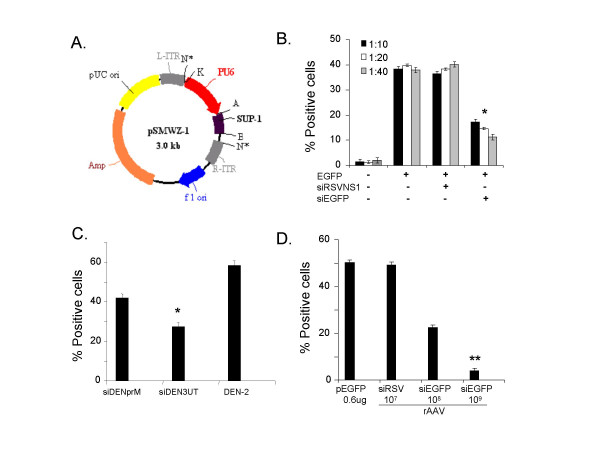
Construction and characterization of the siDEN suppressor. (A) Diagram of the construction of the plasmid vector, pSMWZ-1, capable of expressing a DEN infection suppressor cassette. Abbreviations: N*, Not I; K, Kpn I; A, Apa I; E, EcoR I; SUP-1, Suppressor cassette; (B) Co-transfection with pSMWZ-siEGFP and pEGFP inhibits the expression of EGFP in cultured cells. HEK293 cells were transfected with different concentrations of plasmid DNA and three days later, EGFP-positive cells were counted by fluorescence microscopy. Results are expressed as mean ± SEM. *p < 0.05 compared to control (siRSVNS1, an unrelated siRNA construct against respiratory syncytial virus). (C) pSMWZ-siDEN suppression of DEN-2 virus replication. Vero cells were transfected with pSMWZ-siDEN3UT or pSMWZ-siDENpreM plasmid. Two days later, the cells were infected with DEN-2 virus (MOI of 0.1) and 5 days later, the numbers of DEN-2 virus infected cells were counted by fluorescence microscopy. Data are mean ± SEM. *p < 0.05 compared to control DEN-2. (D) AAV-siEGFP inhibits the expression of EGFP in cultured cells. HEK293 cells were infected with different concentrations of AAV-siEGFP, and three days later the cells were transfected with pEGFP. EGFP-positive cells were counted by fluorescence microscopy. Statistically significant differences, **p < 0.01, when compared to pEGFP plasmid control, AAV-siRSV (107) and AAV-siEGFP (108) group, respectively.